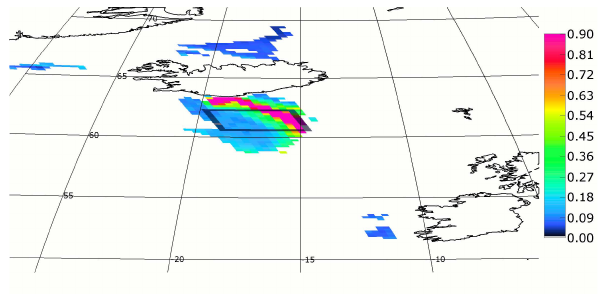
Fig. 2. Aerosol optical thickness retrieved at 0.865µm by POLDER over ocean cloud-free pixels south of Iceland. The AOT values are relative to the PARASOL overpass of 7 May 2010. The microphys- ical and optical properties of the aerosols observed for the area in the black box are depicted in detail in Fig.